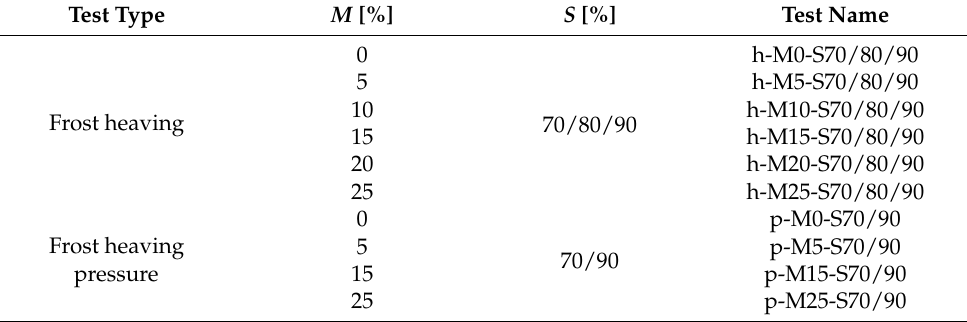
Table 2. Details of frost experiments conducted in this